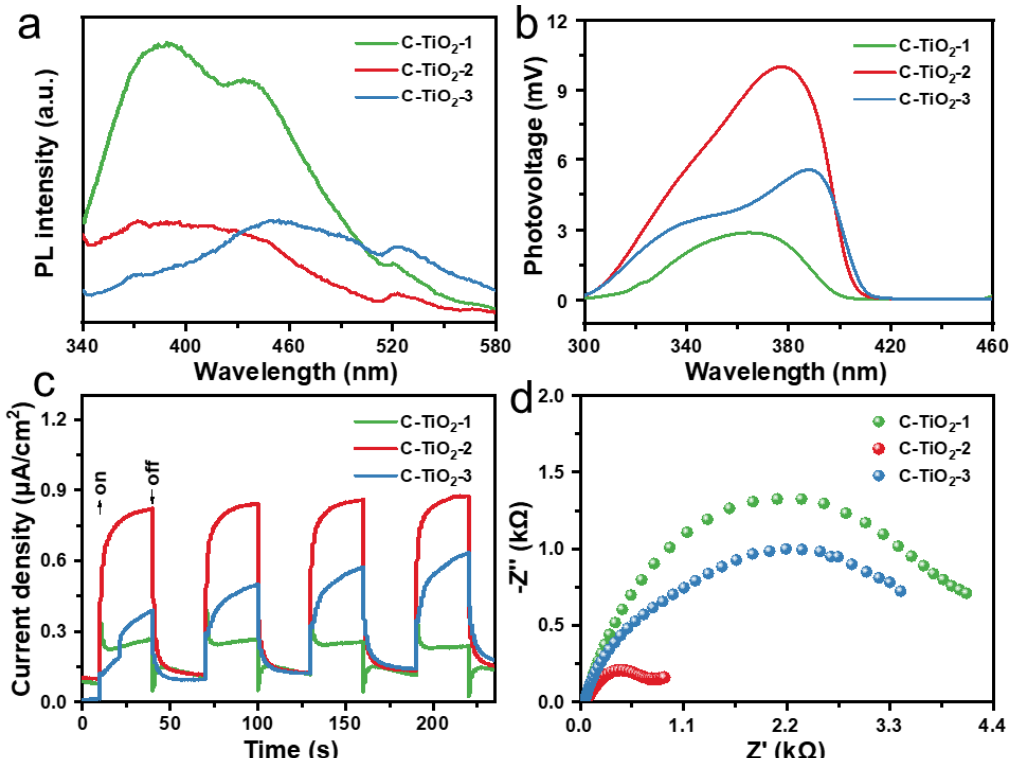
Figure 7. ( a ) Photoluminescence spectra. ( b ) Surface photovoltage (SPV) amplitude spectra at the nanoscale level under illumination from 300 to 460 nm. ( c ) Photocurrent responses and ( d ) Nyquist plots of as-prepared samples under light irradiation.